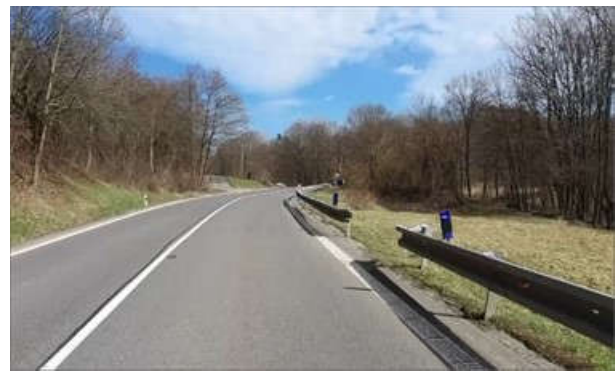
Figure 2. Incorrect beginning/end of the crash barrier.